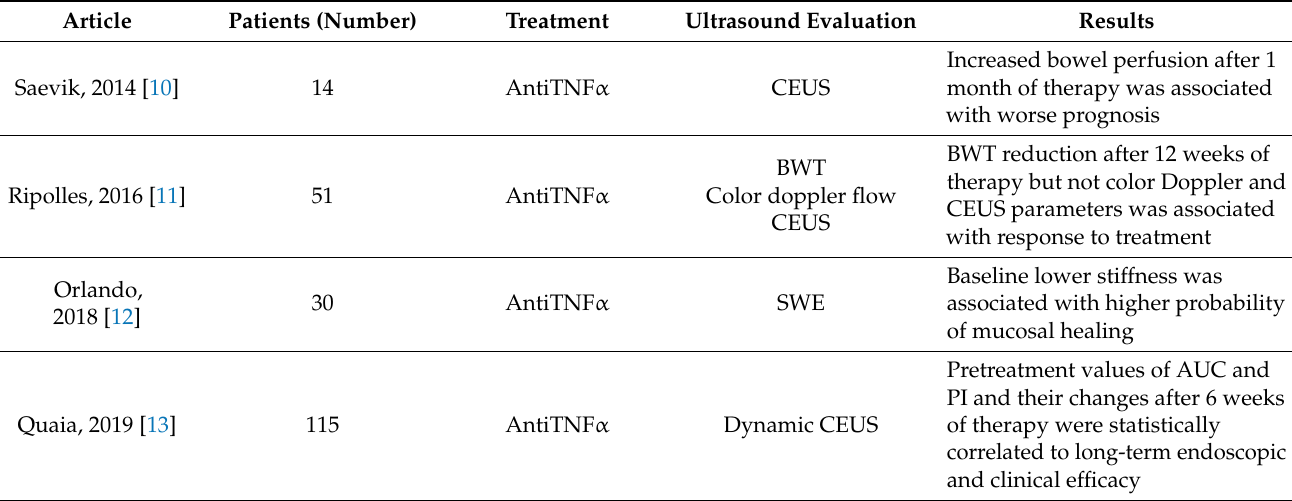
Table 1. Multiparametric ultrasound evaluation of response to biological treatment in patients with Crohn’s